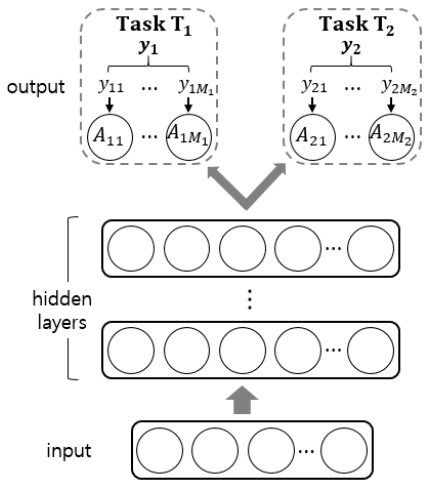
Figure 2. Extended output representation for two independent tasks 𝐓 𝟏 , 𝐓 𝟐 .